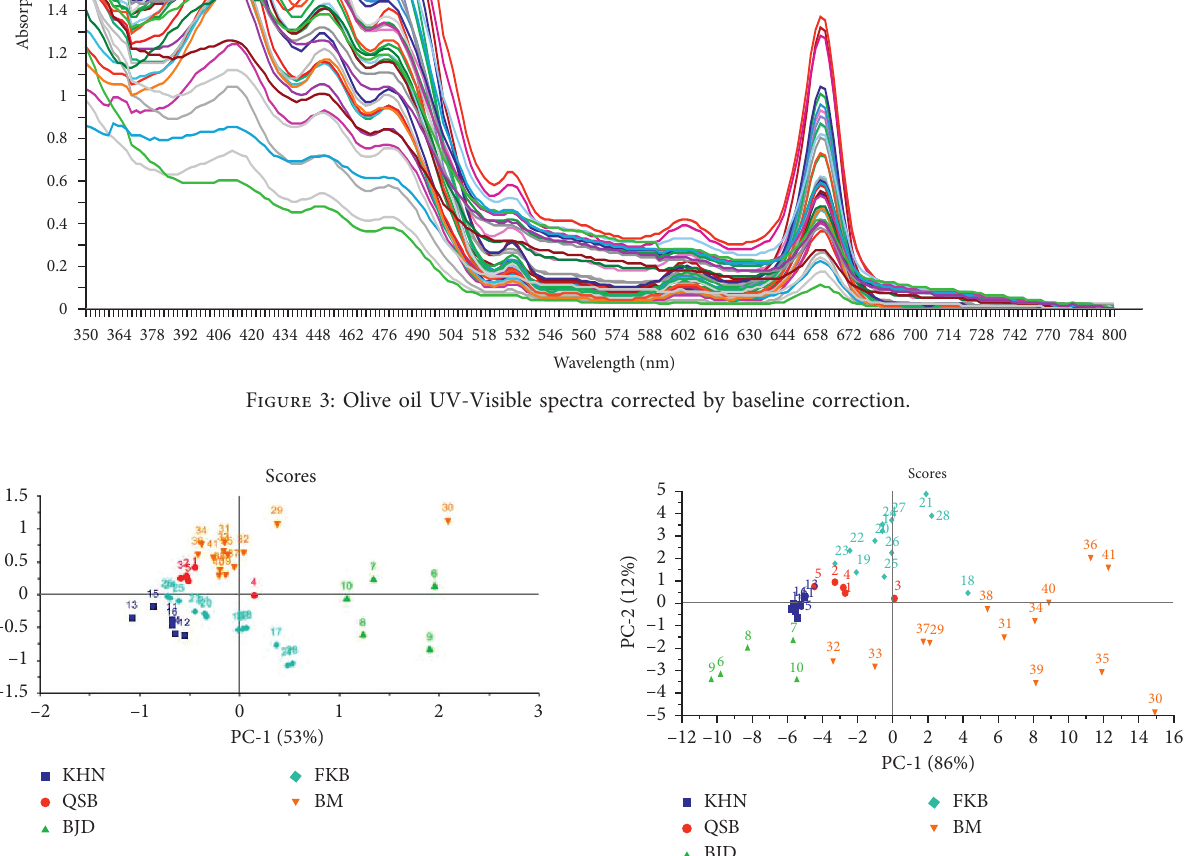
Figure 4: The PCA score plot of ATR-FTMIR spectra at the PC1- PC2 plan. Figure 5: Score plot of UV-Visible spectral data without spectral correction at the PC1-PC2